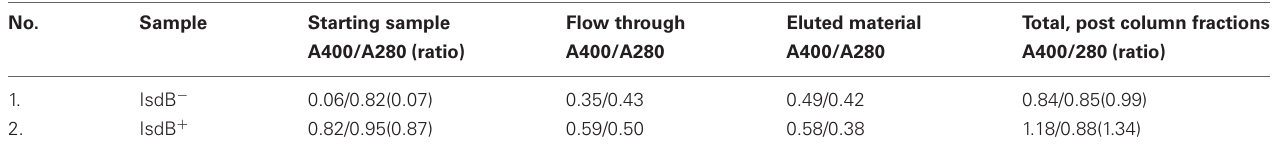
Table A1 | IsdB interaction with immobilized human hemoglobin.